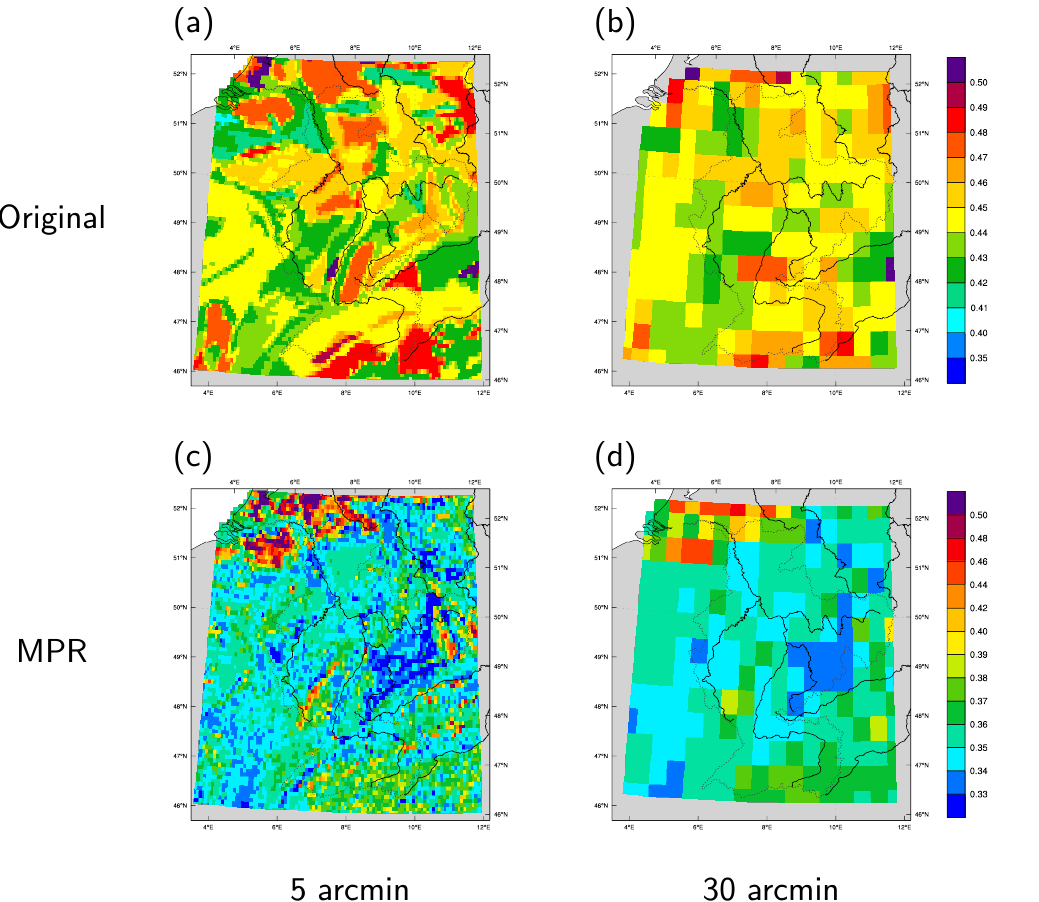
Figure 8. Porosity fields of PCR-GLOBWB before (a, b) and after implementing MPR (c, d) for two spatial resolutions of 5 and 30arcmin. Dotted lines denote the Rhine Basin and the continuous line is the main EU river basin